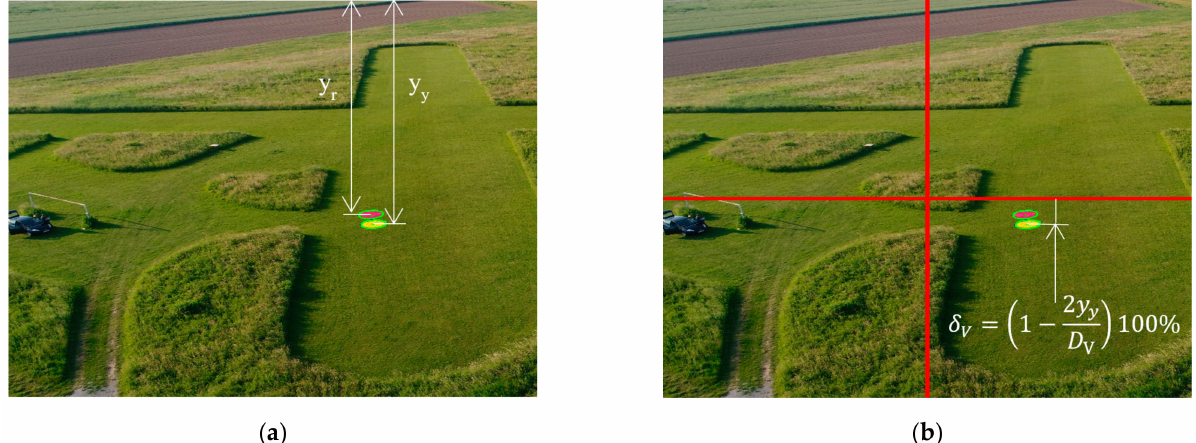
Figure 7. ( a ) Identified and contoured ground signs system appearing to the on-board vision system with marked centers of circles; ( b ) yellow circle’s relative positon δ V to the horizontal center of the picture, D V is the height of the picture in